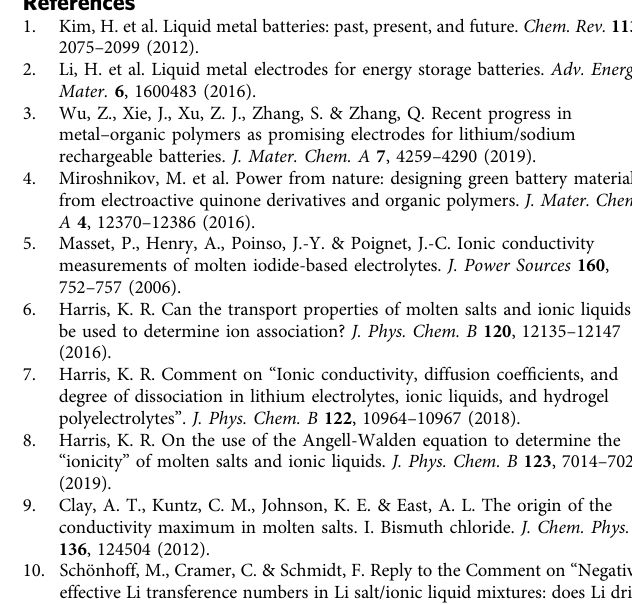
Supplementary Figs. 6 – 8. For comparison, a ternary plot of the experimental conductivity values is provided in the Supplementary Note 7 and Supplementary Fig. 10. For the non-equilibrium simulations (2 ns, NVT), an external electric fi eld (0.1, 0.2, 0.3, and 0.4Vnm − 1 ) was applied to the different equilibrated simulation boxes and the drift velocity in the electric fi eld direction was evaluated. The electric fi eld is modeled by applying an extra force in x-direction on each particle with F i = q i E x . In comparison to a real system with physical electrodes, also in a simulation, there may exist screening effects. Because of asymmetric distribution of ions in an electric fi eld Fig. 3, a counter- fi eld is generated 61 , which may affect the electrical mobility. However, in contrast to a real system, there is no interface between the molten salt and the electrode in the simulation. Therefore, the simulations are representative of the bulk of a system that is exerted to an electric fi eld.